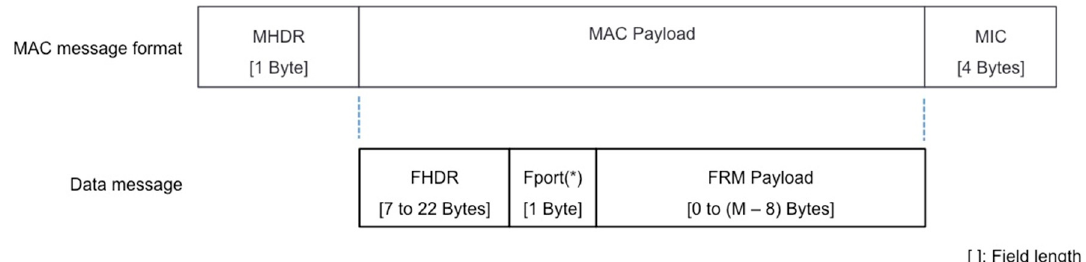
Figure 4. LoRaWAN Medium Access Control (MAC) message format. The (*) FPort field is